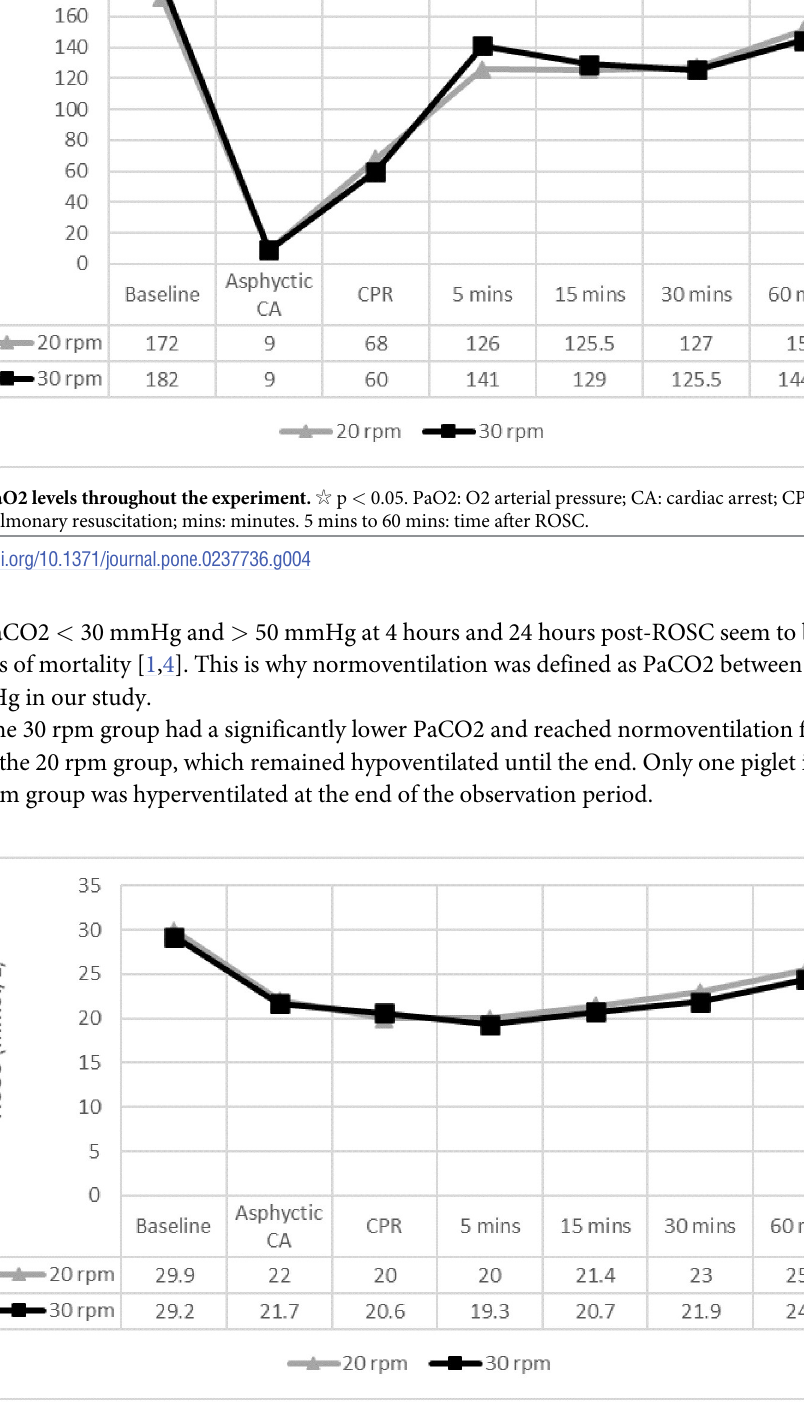
Fig 5. HCO3 levels throughout the experiment. ✩ p < 0.05. HCO3: bicarbonate; CA: cardiac arrest; CPR: cardiopulmonary resuscitation; mins: minutes. 5 mins to 60 mins: time after ROSC.